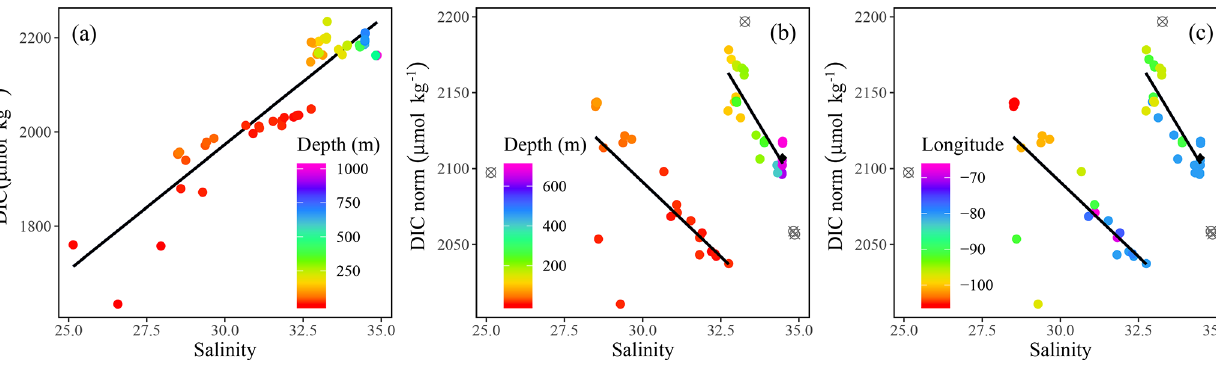
Figure 5. (a) Dissolved inorganic carbon (DIC) and (b) salinity-normalized dissolved inorganic carbon (DIC norm ) were plotted against salinity ( S P ) with the colors indicating (a, b) depth (m) and (c) longitude. The DIC vs. S P regression yields DIC = ( 53 . 4 ± 2 . 8 ) × S P + 371 ± 89 ( R 2 = 0 . 86). The DIC norm vs. S P plots were fitted with a piecewise regression analysis representing the surface, DIC norm = ( − 19 . 7 ± 3 . 9 ) × S P + 2681 ± 120 ( R 2 = 0 . 5), and at depth, DIC norm = ( − 34 . 2 ± 3 . 5 ) × S P + 3282 ± 117 ( R 2 = 0 . 76). In panels (b) and (c) CB4 was excluded from the piecewise regression (represented by unfilled, crossed out gray circles), whereas the surface samples from stations 312 and 314 were excluded entirely. The black diamonds identify the average Atlantic deep-water samples from stations CAA1, CAA2, and